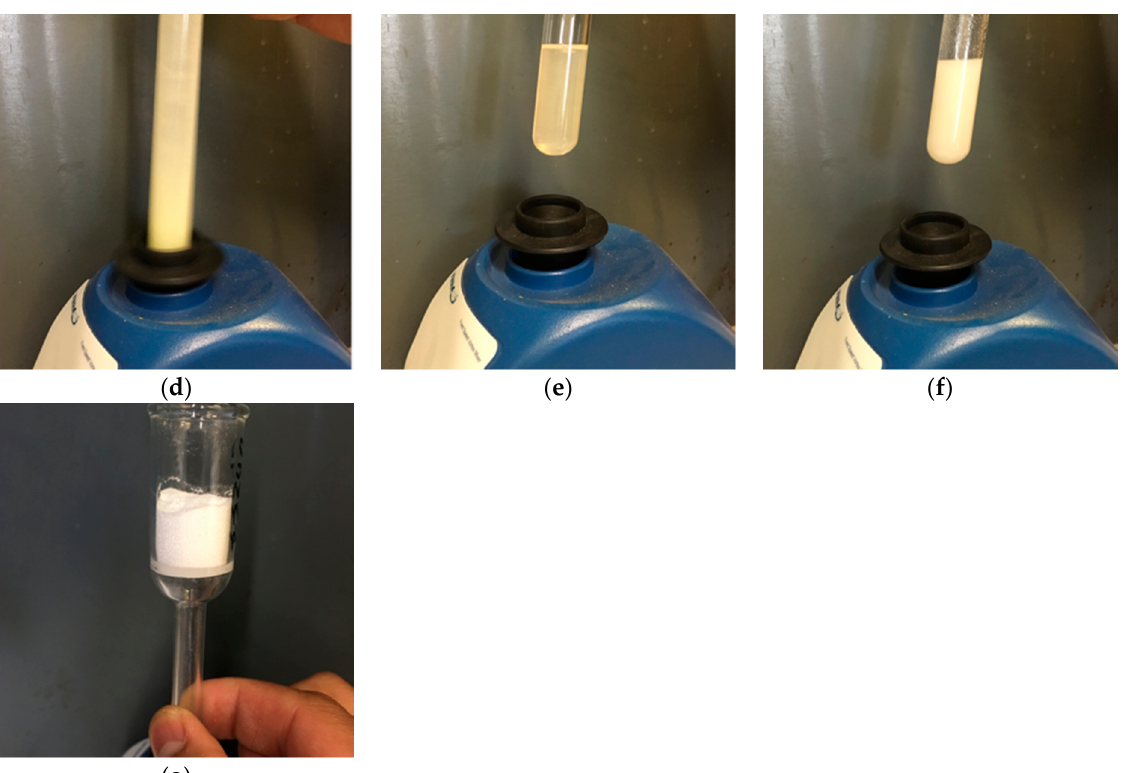
Figure 1. Description of the procedure. ( a ) Commercially available flake triphenylphosphine (2.62 g, 10 mmol); ( b ) Addition of yellow sulfur (320 mg, 10 mmol); ( c ) Addition of CH 2 Cl 2 (5 mL), t = 0; ( d ) The reaction mixture was shaken vigorously with mechanical shaker; ( e ) Both solid materials disappeared progressively. At t = 30 s, the reaction mixture became nearly homogeneous to yield a pale-yellow solution; ( f ) t = 40 s, triphenylphosphine sulfide precipitated as a white solid; ( g ) The reaction mixture was filtered, the precipitate was washed with MeOH (2 mL × 3) and dried. Yield = 2.59 g (88%).